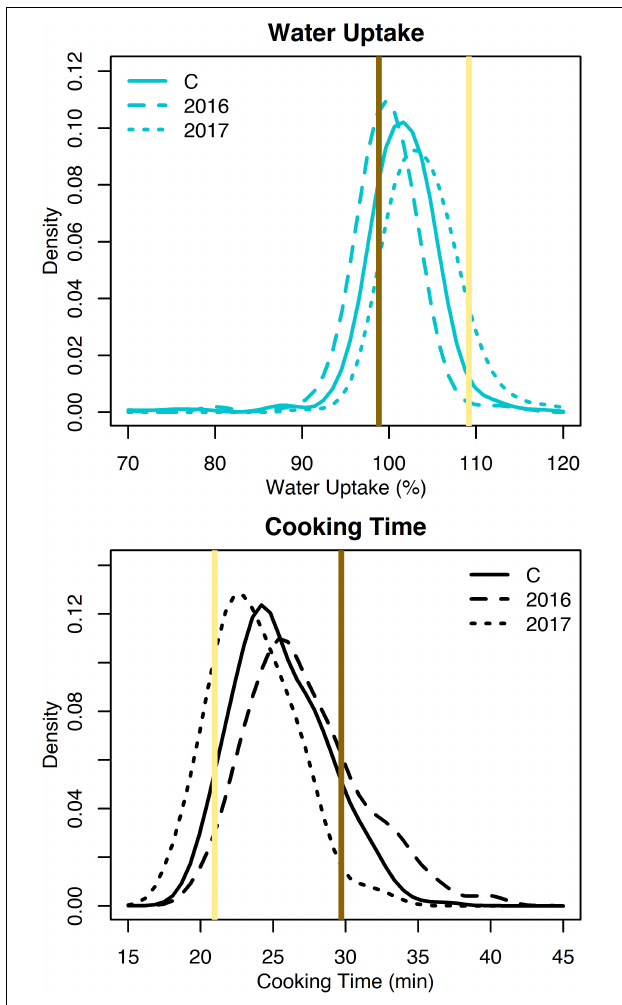
FIGURE 2 | Density plots of water uptake and cooking time for the RILs from 2016, 2017, and both years combined (C). Means for Ervilha and PI527538 from both years combined are indicated in yellow and brown,